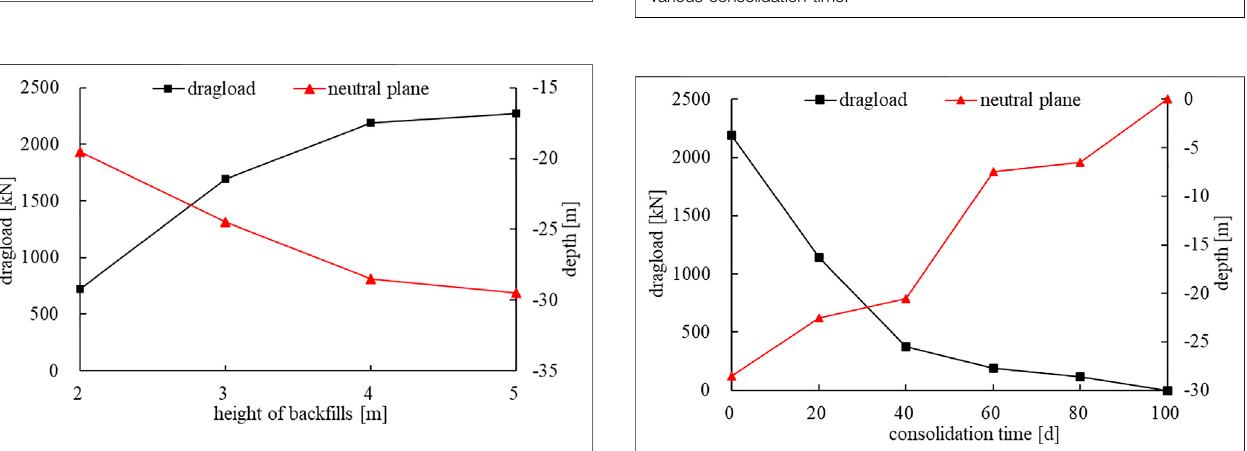
FIGURE 8 | Distribution of axial forces on PHC pile determined for various consolidation time.